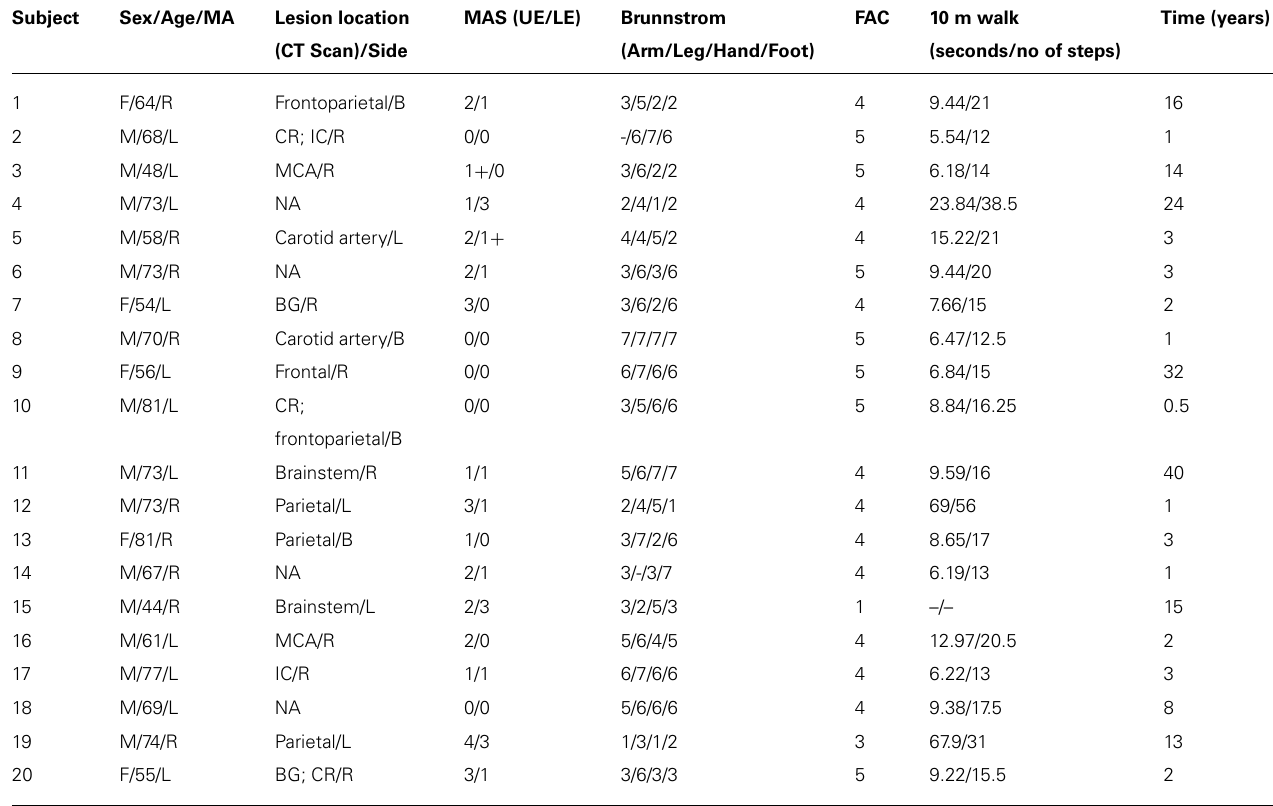
Table 1 | Participant data and clinical assessment